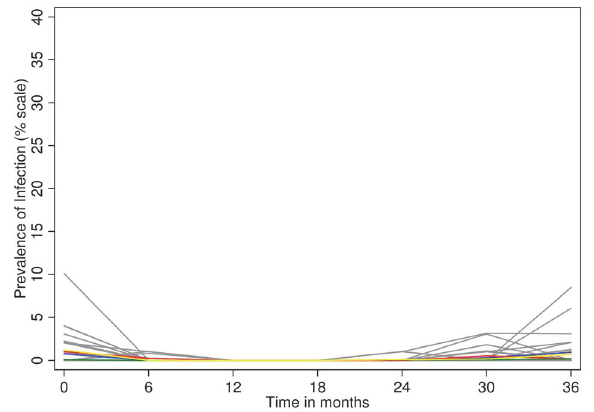
Figure 4. Cluster summarized mean percentage prevalence of TF by study arm (blue: standard 3 6 , red: , enhanced 3 6 , green: standard SR, yellow: enhanced SR and by individual EA within study arm(grey lines) at each time point.